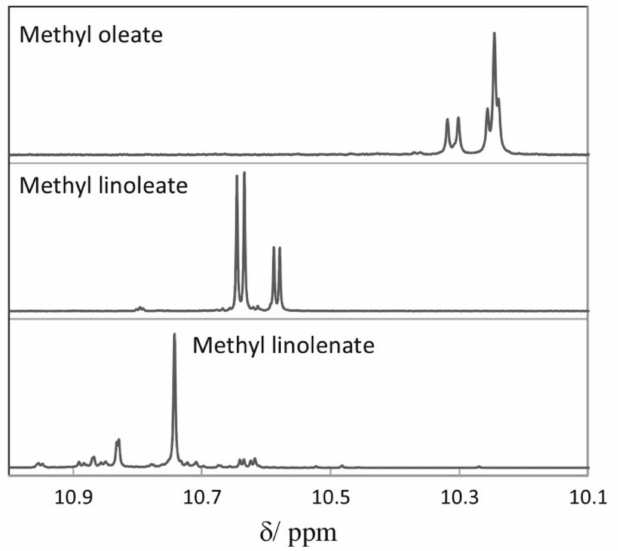
Figure 29. Hydroperoxide-proton region of oxidized oleic acid, linoleic acid, and linolenic acid standards. Reprinted with permission from [130]. Copyright 2012,